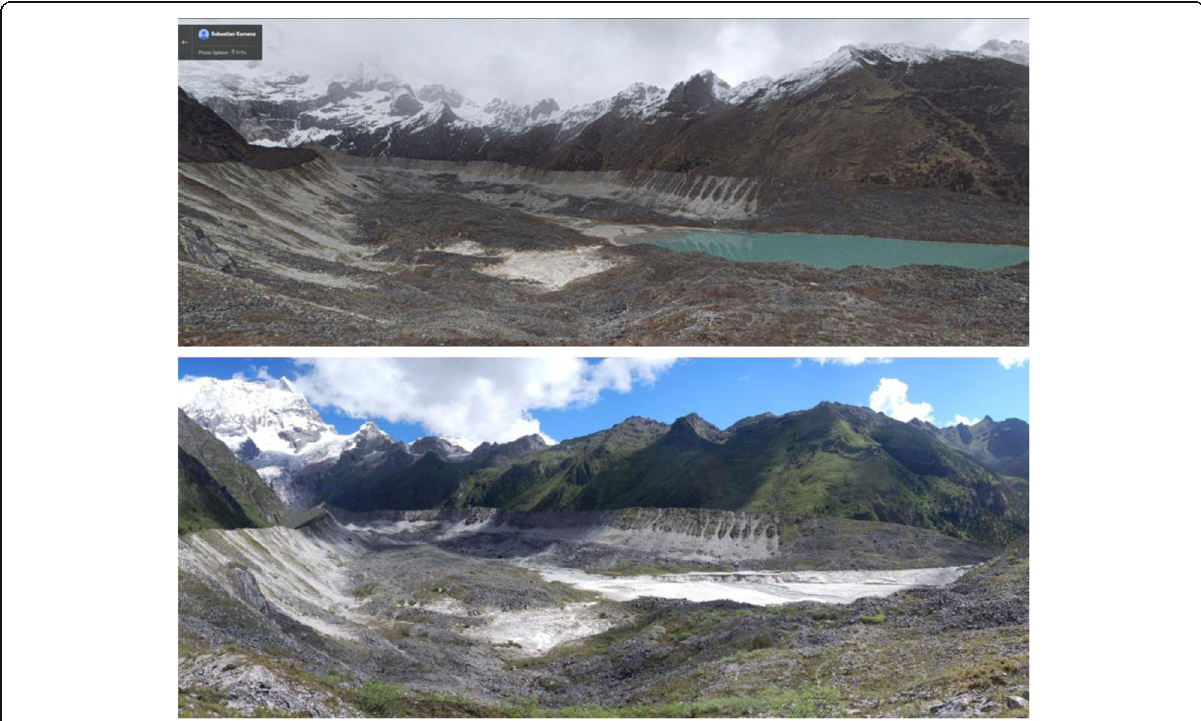
Fig. 2 Repeat photograph of Lemthang Tsho: top (pre event, May 2015) and bottom (post event, July 2015). Photo credit: Sebastian Kammer and Sharad